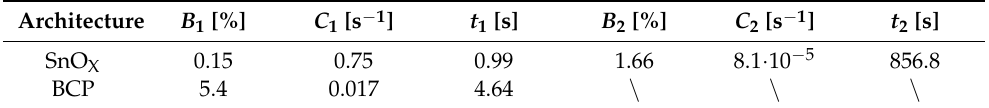
Table 2. Short-circuit current fitting